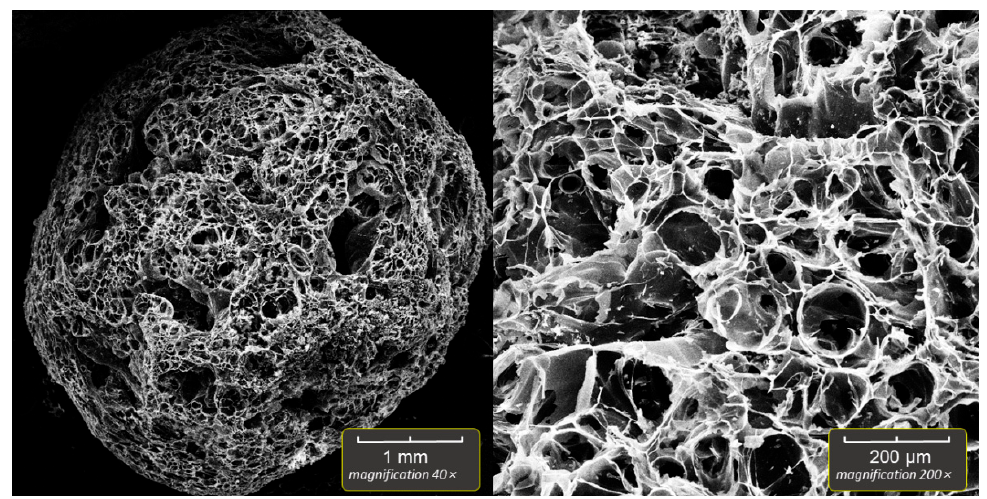
Figure 4. The surface of a perlite particle imaged by SEM.